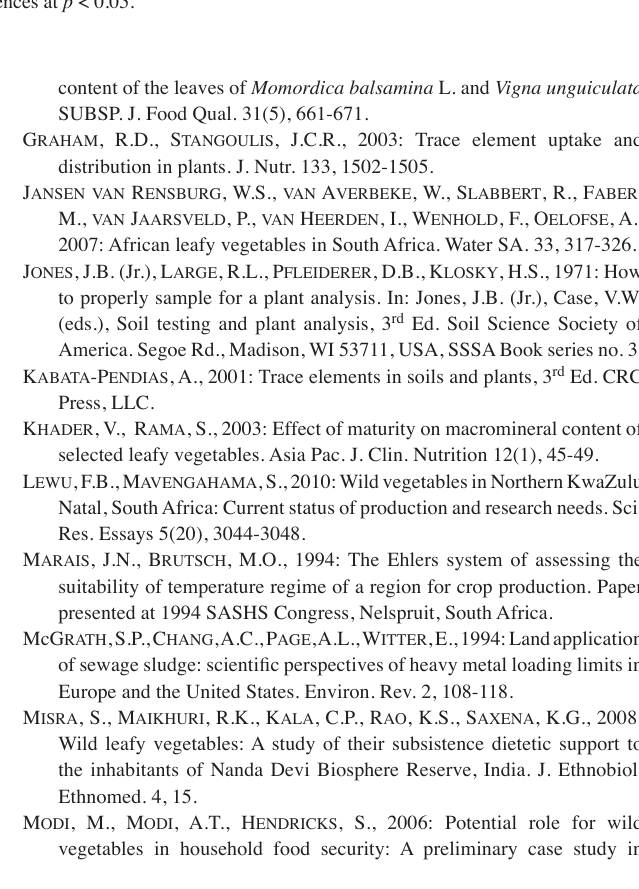
Plant age (Weeks after transplanting)